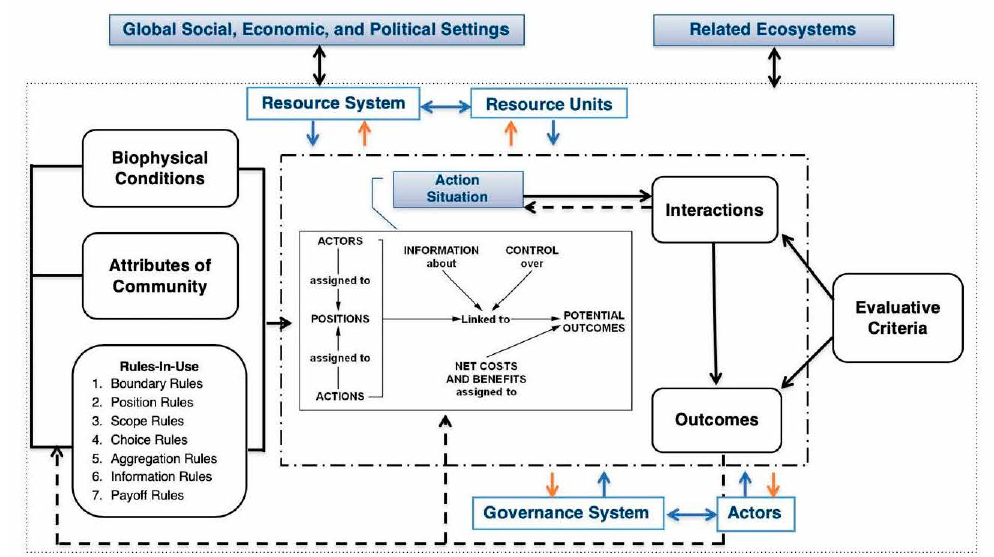
Figure 5. Institutional Analysis and Development (IAD) Framework. This adaptation of Ostrom’s IAD framework is to include the wider tiers of backgrounds in which human behaviours are deeply embedded. Start with the micro operational level of action arena (in the centre), which is to map out diverse actors and a sophisticated action situation. Second step is to identify resulting patterns of interactions & outcomes. The evaluation should be on both interactive process and the outcomes. This helps us to understand the evolving dynamics and possible institutional/policy alternatives. The next step is to draw out direct causal links & feedbacks between the evolving dynamics and the resource system & governance system over a longer period of time. Biophysical conditions, local attributes and rules in use are external factors, but they too have direct impacts on the action arena. While the interactive patterns would also have feedbacks towards those external factors, for instance, change the rules in use. Global settings & interdependent ecosystems could also influence the entire process through underling divergent or convergent values. For instance, the profound neo-liberal logic of free market and privatisation. Adapted from Ostrom (2005, 2007) and Zhang (2018) [20,21,27].